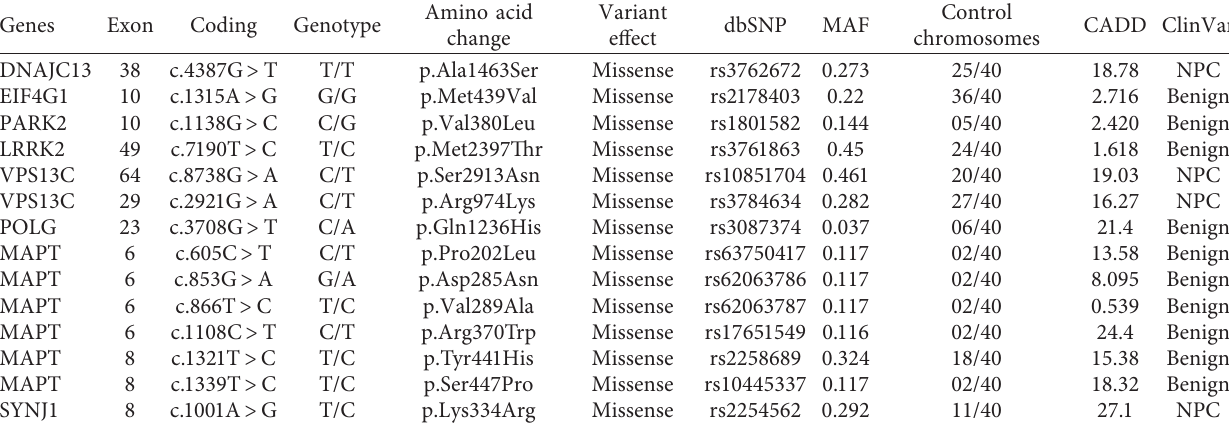
Table 1: Functional mutations obtained by 25 gene-panel NGS in patient